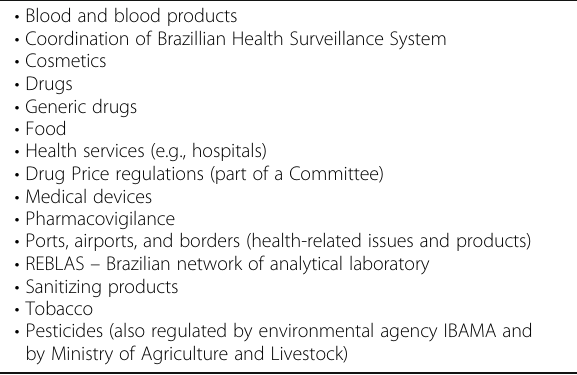
Table 1 Areas regulated by